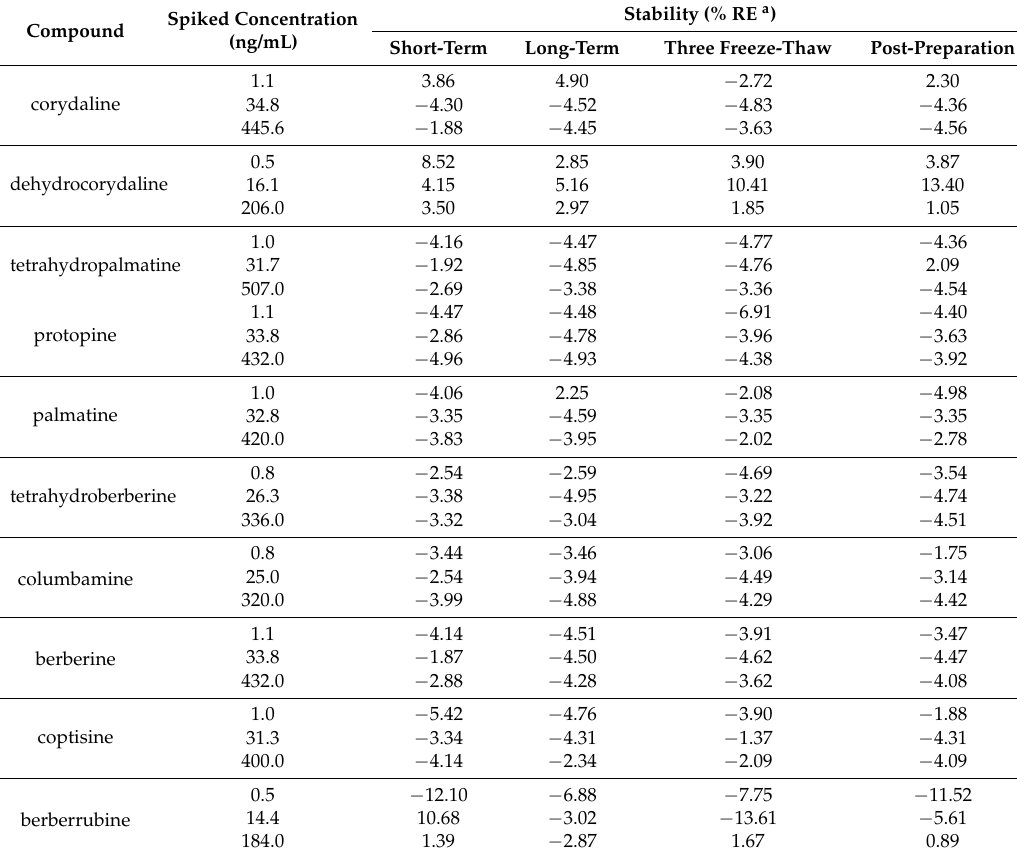
Table 4. Stability data of 10 alkaloids in the beagle dog plasma. ( n = 6).